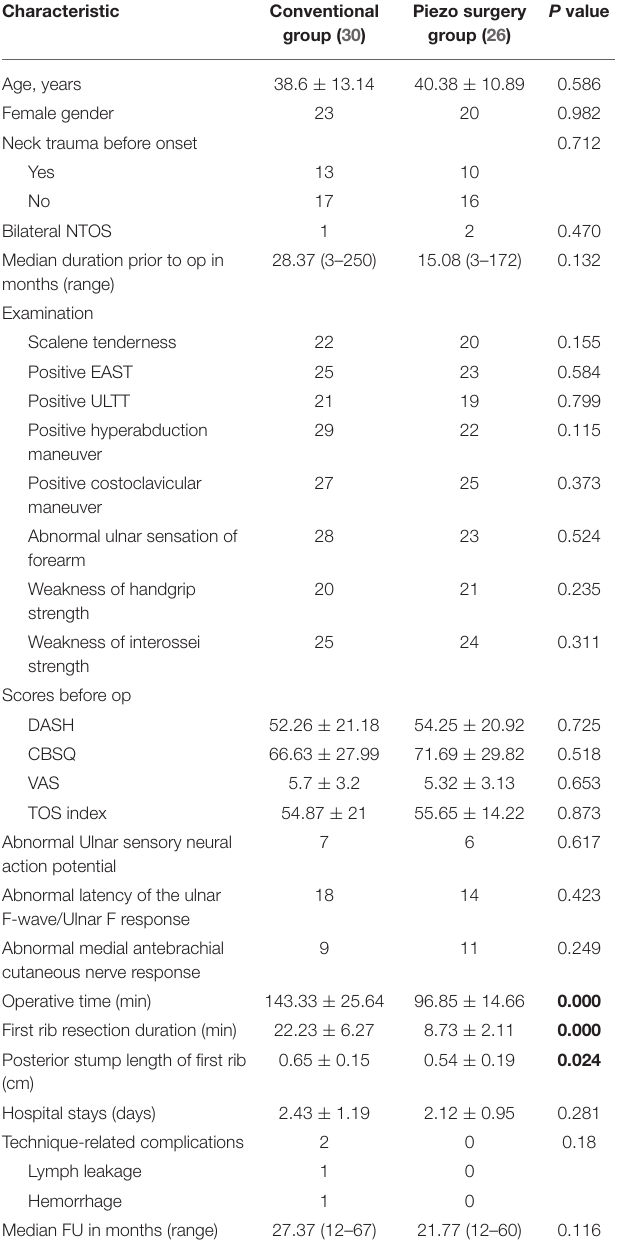
TABLE 1 | Patient characteristics at presentation in the conventional group and piezo surgery group.